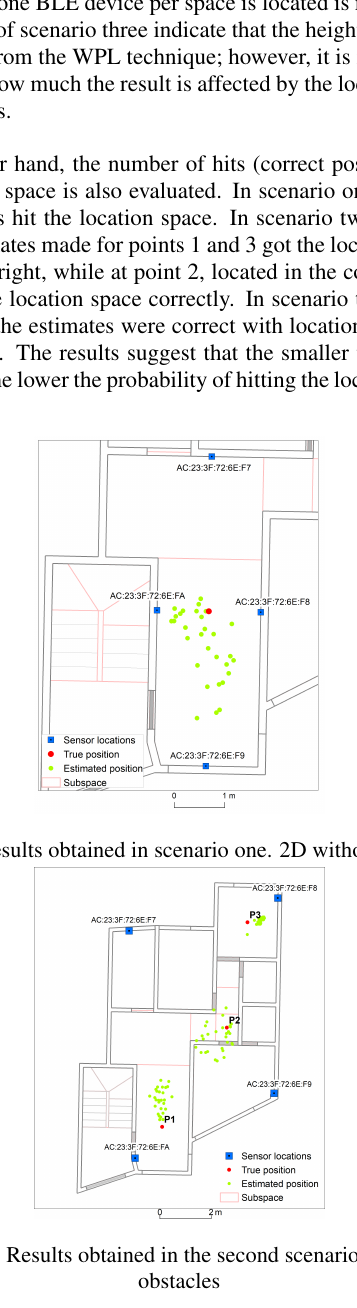
Figure 9. Results obtained in the third scenario. 3D with obstacles